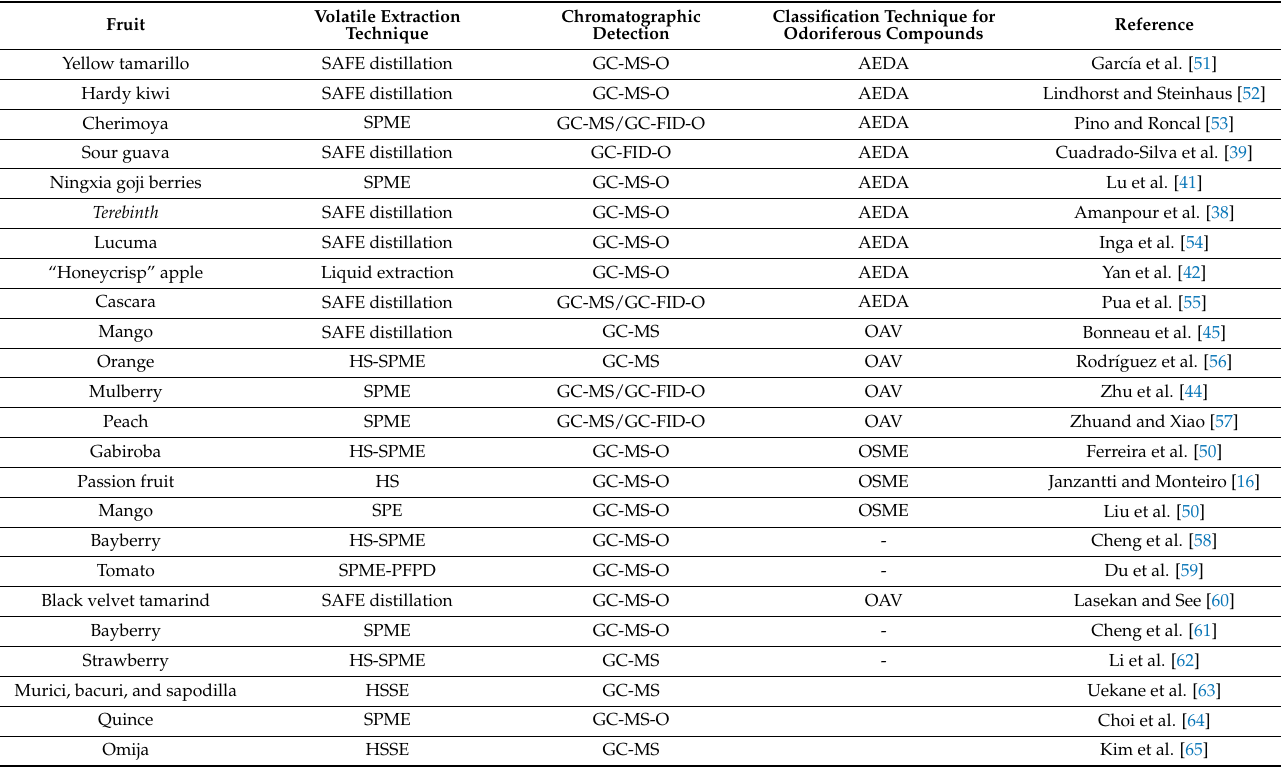
Table 1. Most recent studies (2015–2021) with different techniques for the characterization and evaluation of odoriferous compounds in fruits. Fruit Volatile Extraction Technique Chromatographic Detection Classification Technique for Odoriferous Compounds